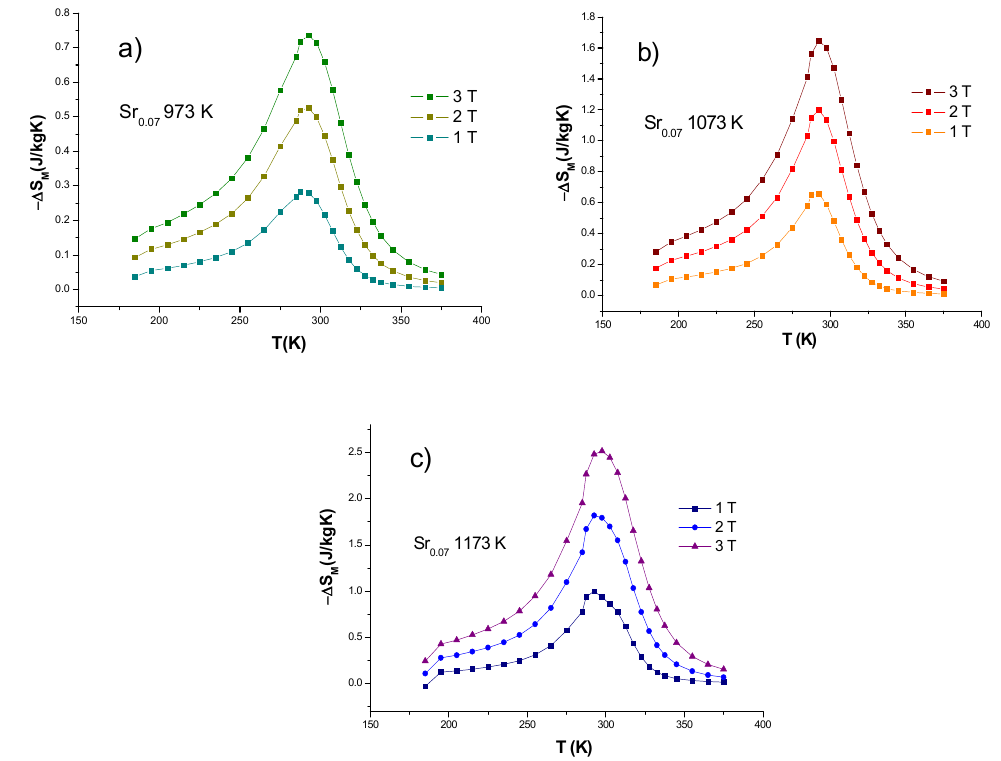
Figure 4. ( a ) Magnetic entropy change for thermal treatment of 973 K. ( b ) Magnetic entropy change for thermal treatment of 1073 K and ( c ) magnetic entropy change for thermal treatment of 1173 K. As measured under applied magnetic field of μ 0 H = 1, 2 and 3 T.